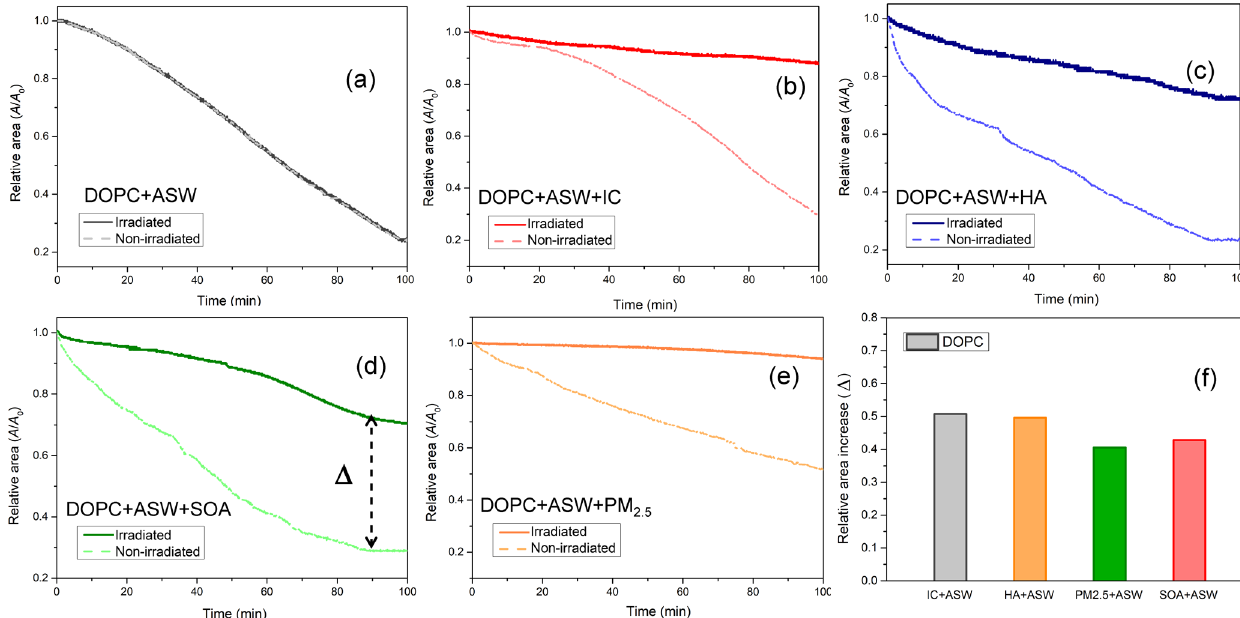
Figure 4. (a–e) Relative area ( A/A 0 ) curves of the irradiated and non-irradiated DOPC monolayers on artificial seawater containing IC, HA, PM 2 . 5 , and SOA samples, respectively. (f) Relative area increase ( (cid:49) ) in the DOPC monolayer after 90min irradiation; A 0 is the molecular area of the monolayer at 25mNm − 1